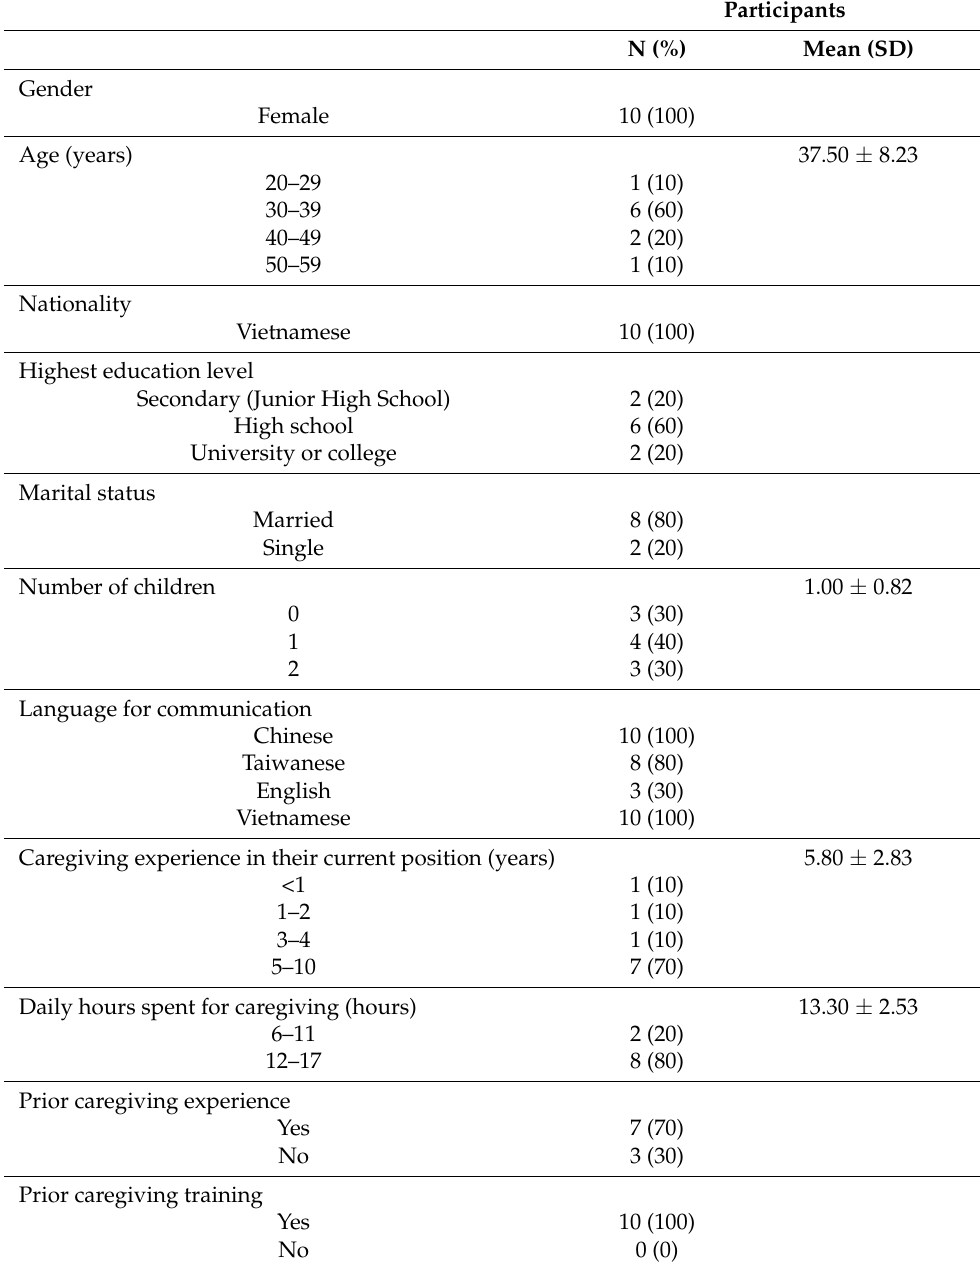
Table 2. Demographics of